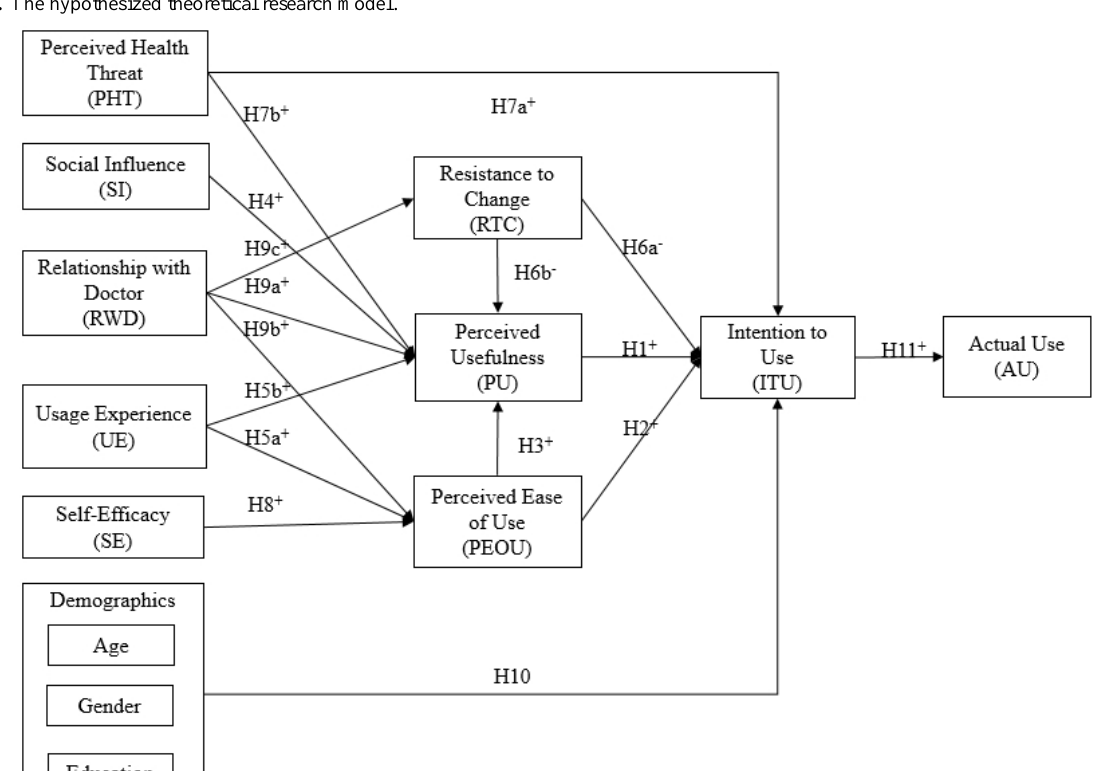
Figure 1. The hypothesized theoretical research